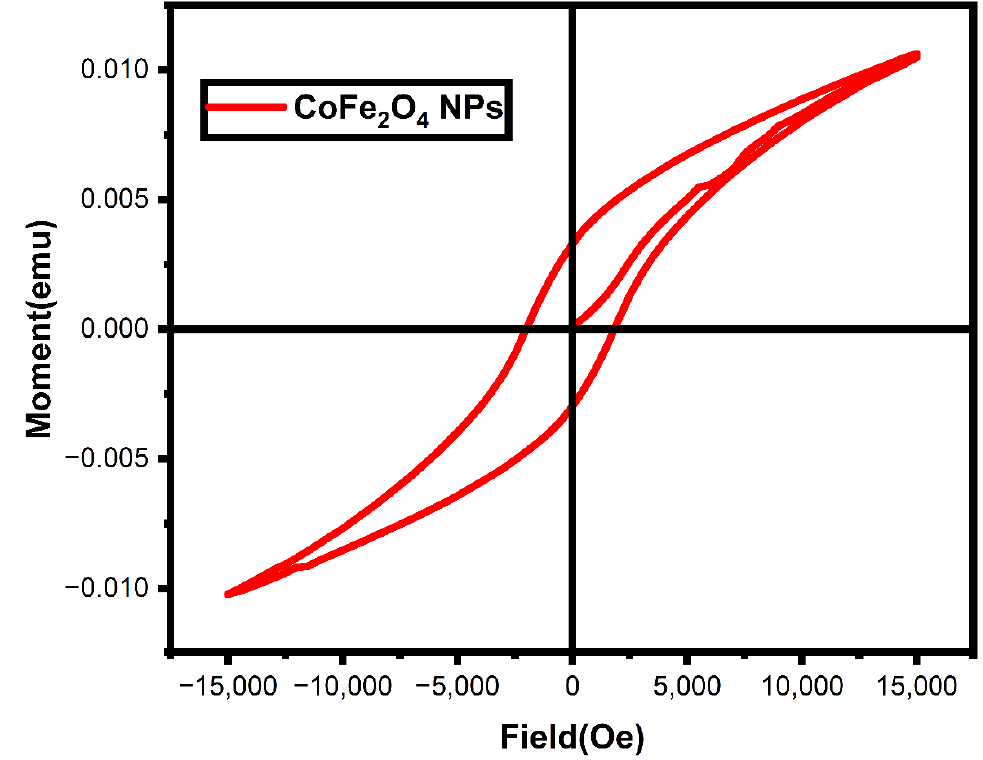
Figure 4. VSM spectrum of biosynthesized CoFe 2 O 4 nanoparticles.